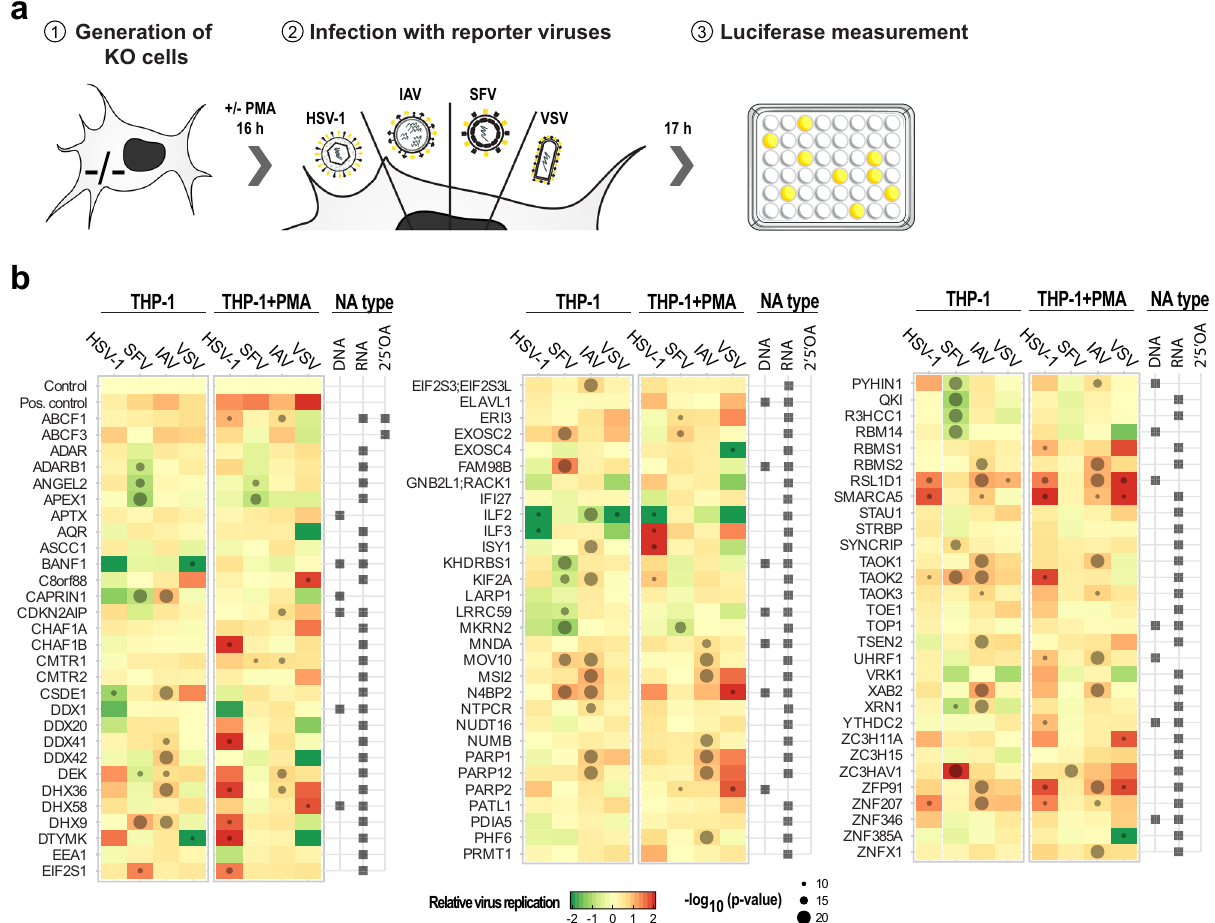
Fig. 3 Antiviral activity of identi fi ed candidate proteins in human cells. a Schematic of the screening strategy to test for virus-modulating activities of candidate proteins. THP-1 cells were infected with a pool of three lentiviruses expressing individual sgRNAs against the target protein or controls as well as CRISPR/Cas9 and selected for 16 days. Control: average of four pools of nontargeting sgRNAs; pos. control: STAT1 . Cells were left undifferentiated or differentiated for 16 h with 150 nM PMA and infected with luciferase-tagged viruses (VSV-FLuc at MOI 0.1, IAV-GLuc at MOI 0.1, SFV-GLuc at MOI 0.1, and HSV-1-FLuc at MOI 0.2). After 24 h the accumulation of luciferase signal was analyzed. b Heatmap showing the log 2 fold change of the luciferase signal in KO cells as compared to the control (median of the log 2 ( Luc KO /Luc C ) posterior distribution). The two-sided P value is de fi ned as the probability that log 2 ( Luc KO /Luc C ) is different from 0 using a random-effects generalized linear Bayesian model; signi fi cant changes ( p value ≤ 0.05; unadjusted for multiple hypothesis testing) are highlighted with dots. Data represents the median of biological triplicates. Candidates were further categorized into DNA, RNA, and/or 2 ′ 5 ′ OA interacting proteins according to the results of the NA-AP-MS screen. Source data are provided as a Source Data fi